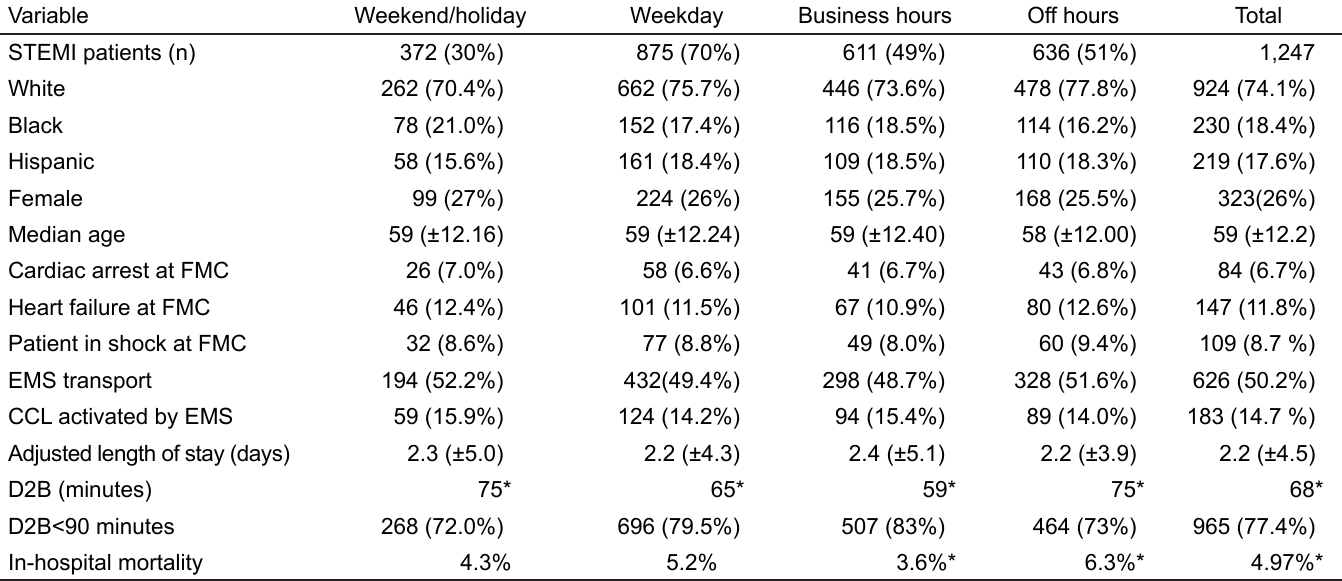
Table 1. Characteristics of STEMI patients by day/time